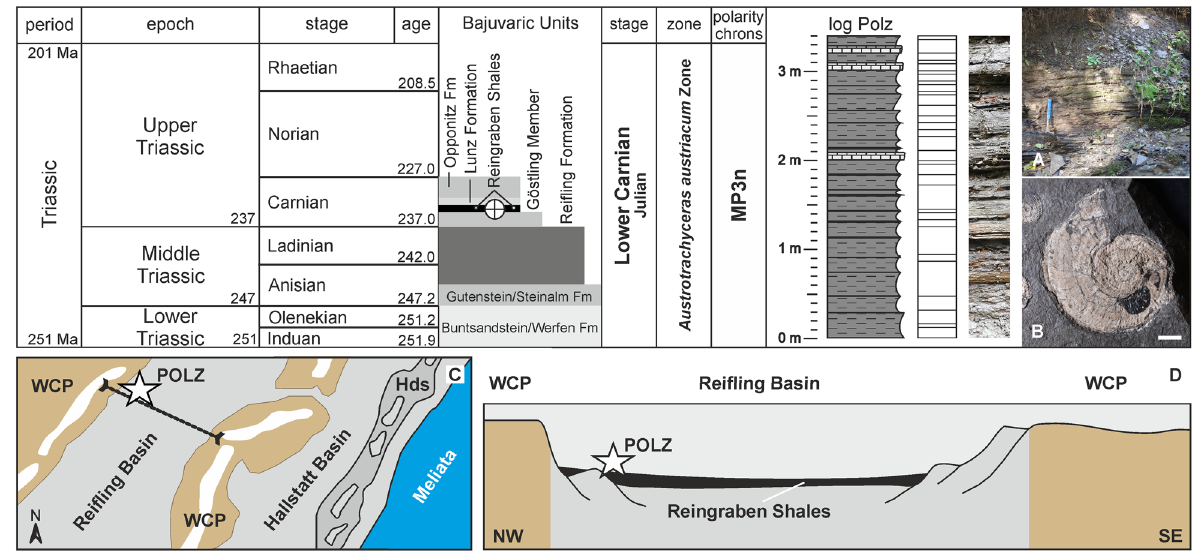
Figure 2. Stratigraphic position of the Reingraben Shales with the layers comprising the Upper Triassic (Lower Carnian) Polzberg palaeobiota within the Austrotrachyceras austriacum Zone. ( A ) Detail of the section